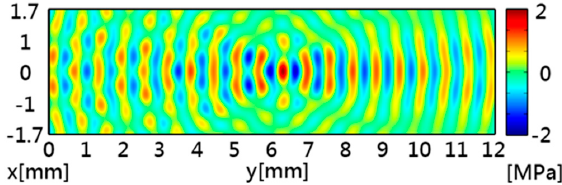
Figure 3. Simulated acoustic pressure of the acoustic tweezers. The maximum acoustic pressure is 1.95 MPa.